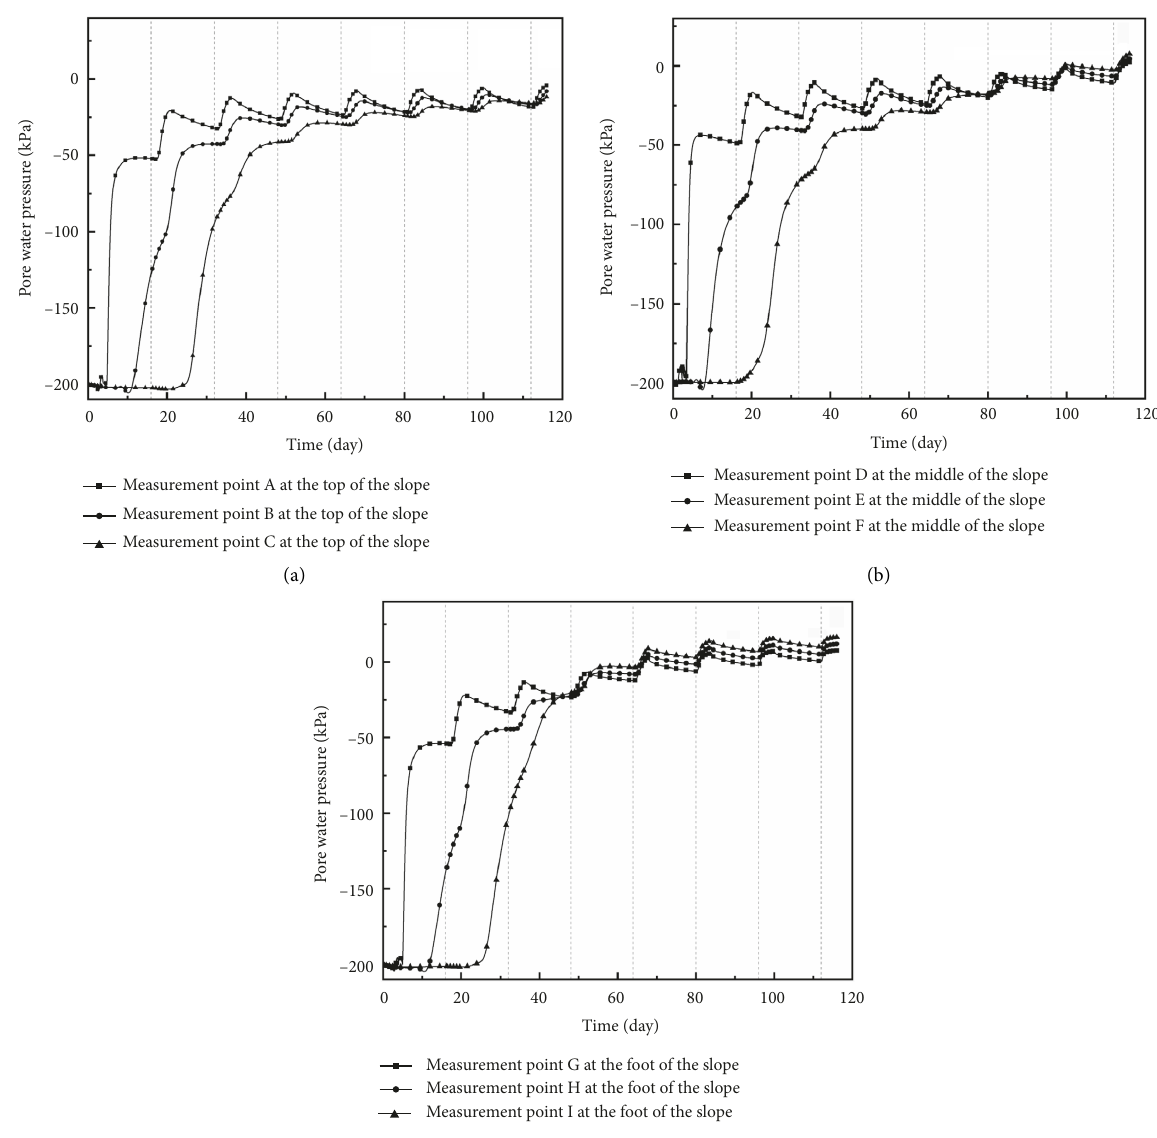
Figure 6: Variation curve of pore pressure at different positions. (a) Pore water pressure variation curve at the top of the slope. (b) Pore water pressure variation curve at the middle of the slope. (c) Pore water pressure variation curve at the foot of the